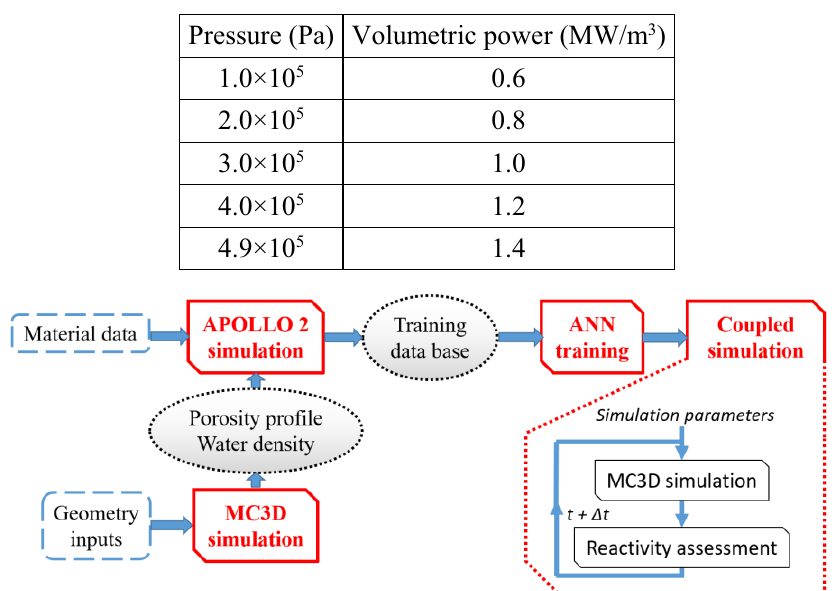
Table I: Used values of pressure and power.